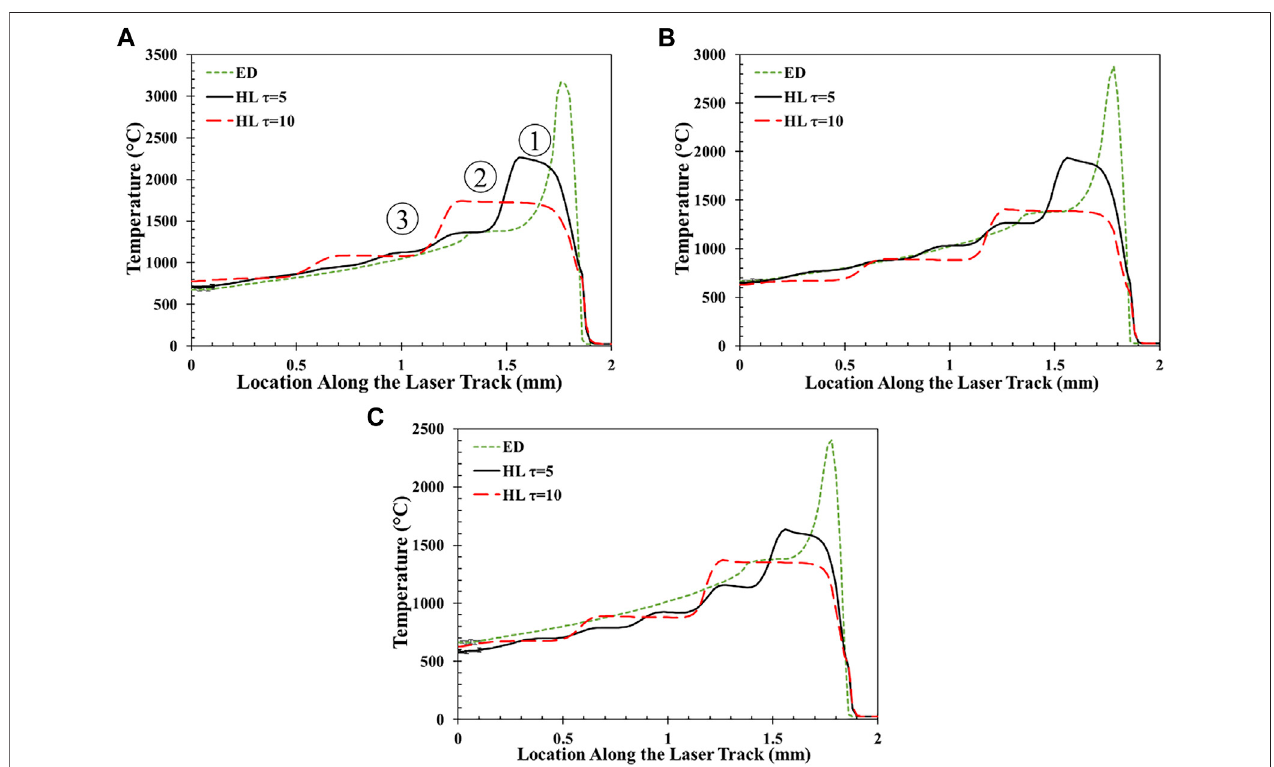
FIGURE12| NodaltemperaturesalonglaserpathsintheEDmodelandtheHLmodelfor τ (cid:2) 5and τ (cid:2) 10.Thelaserpowersandspeedsare (A) 220 W – 800 mm/s (B) 200 W – 1,000 mm/s and (C) 180 W – 1,300 mm/s.